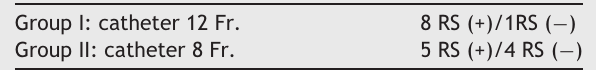
Incidence of rhinosinusitis in the groups of the study by Cetin et al. (2002).